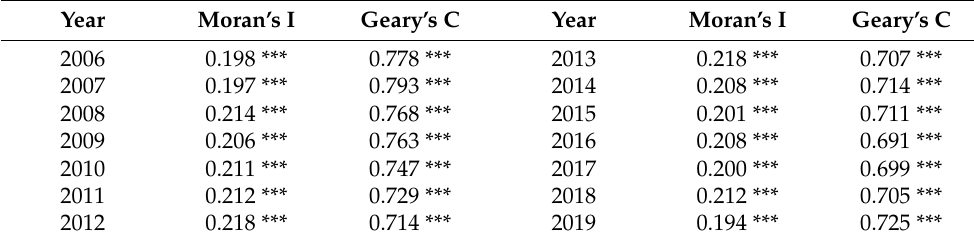
Table 3. Spatial autocorrelation test results of carbon intensity between provinces in